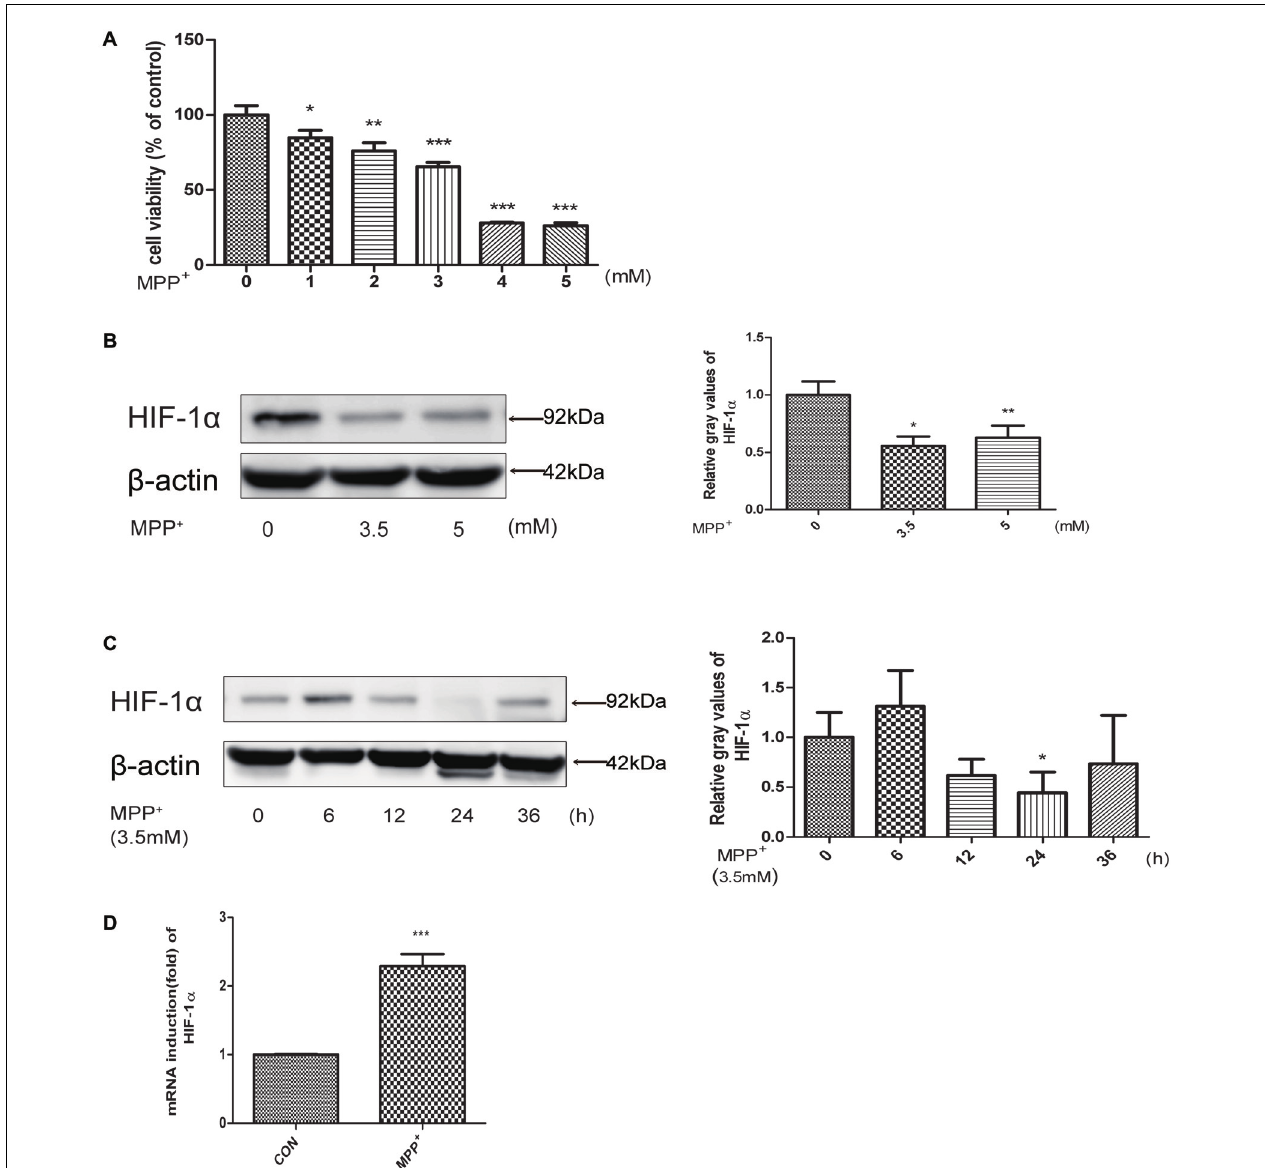
FIGURE 1 | MPP + stimulated the proliferation inhibition, apoptosis and decreased the expression level of HIF-1 α . (A) SH-SY5Y cells were treated with MPP + for 24 h at various concentrations. And then examined the proliferation inhibition rates by CCK-8 method. Western blot and quantification of HIF-1 α protein after MPP + treatment for various concentrations (B) or at 3.5 mM for different time periods (C) . qRT-PCR assay was used to test the changes of HIF-1 α at mRNA level after treated with MPP + for 24 h at 3.5 mM (D) . Data are expressed as mean ± SD. ∗ P < 0.05, ∗∗ P < 0.01, ∗∗∗ P < 0.001( n ≥ 3), compared to the